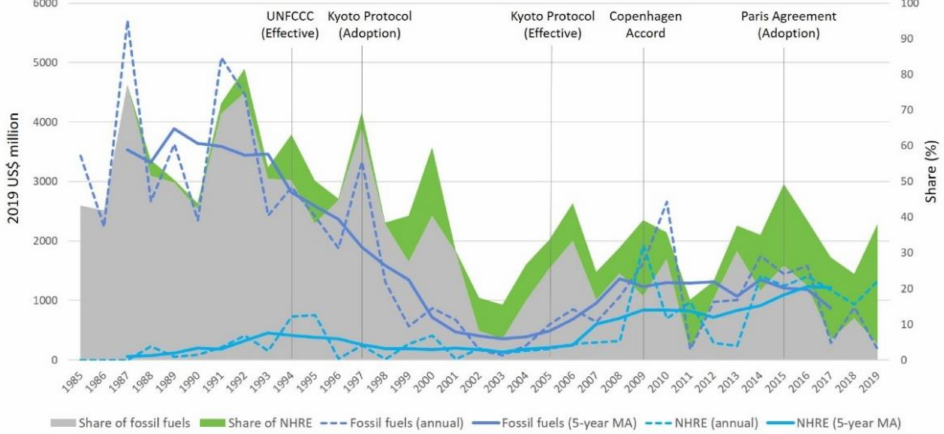
Figure 9. Finance for fossil fuels vs. NHRE (1985–2019). Source: authors’ illustration based on